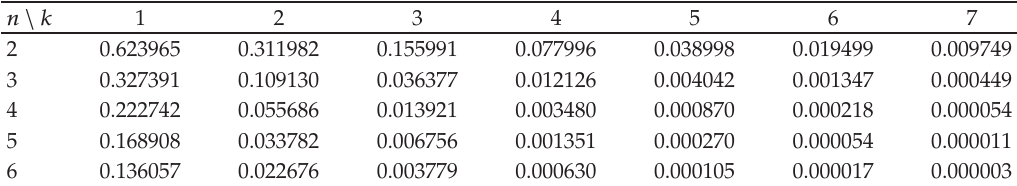
Table 3: Error bound of tensor product n -ary approximating volumetric models: here n presents the arity of subdivision volumetric model and k presents the subdivision level.